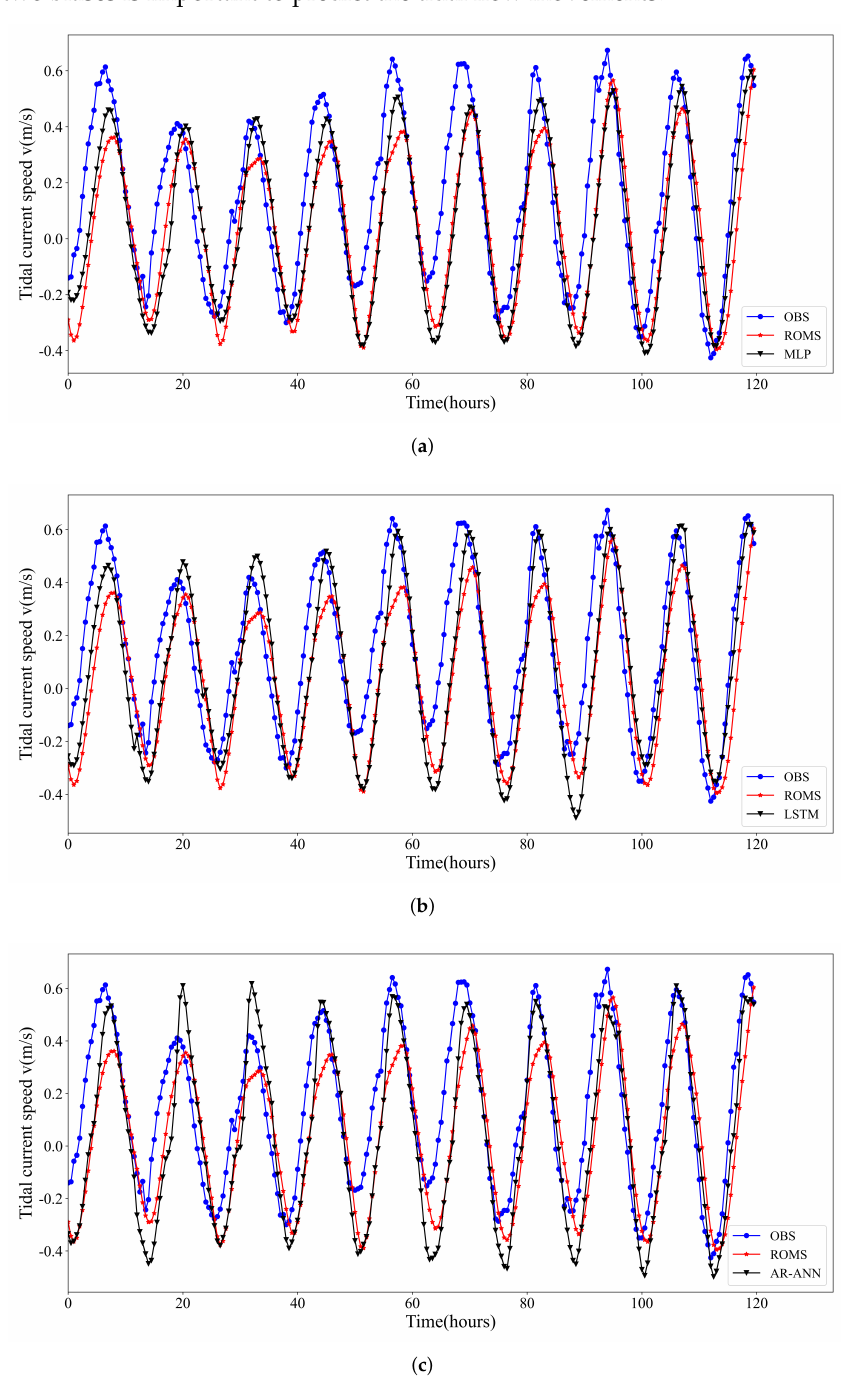
Figure 9. Comparison results of the tidal current speed bias correction by using the three machine learning algorithms. ( a ) Comparison of the MLP method, simulation data and actual value; ( b ) com- parison of the LSTM method, simulation data and actual value; ( c ) comparison of the AR-ANN method, simulation data and actual